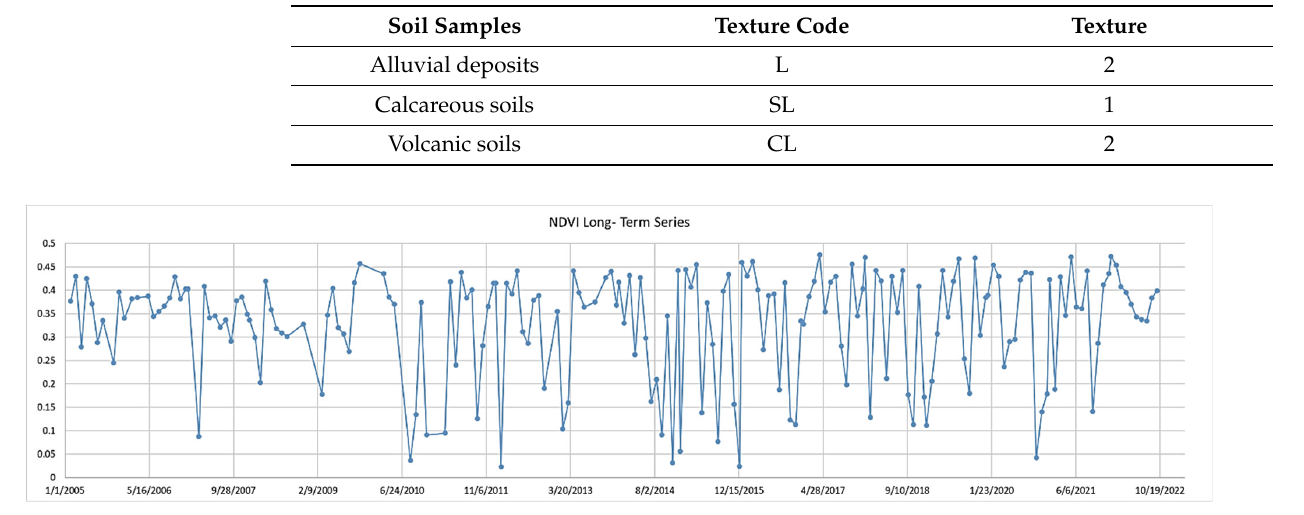
Figure A1. NDVI timeseries 2005–2022 (Google Earth Engine processed).